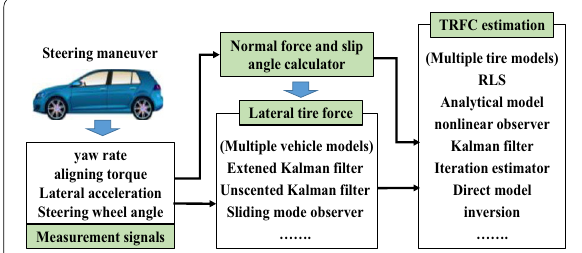
Figure 4 The general framework of TRFC estimation based on vehicle lateral